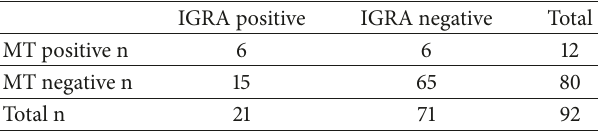
Table 2: Clinical and laboratory profile, N(%). Table 3: MT and Quantiferon TB